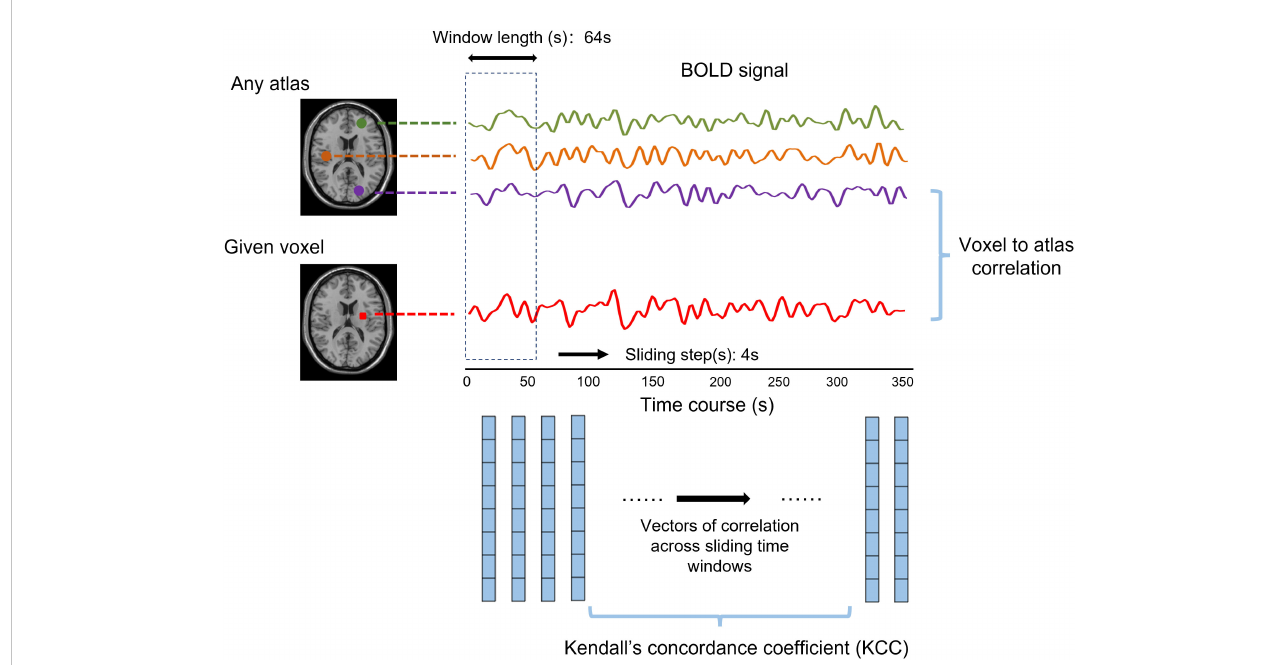
FIGURE 1 The abridged general view shows the calculation method of dynamic functional stability using the voxel-to-atlas way. The Pearson correlation between a given voxel and any atlas, namely, dynamic functional connectivity (dFC), was calculated for each window. The Kendall ’ s concordance coef fi cient was computed based on cross-window dFC to state the functional